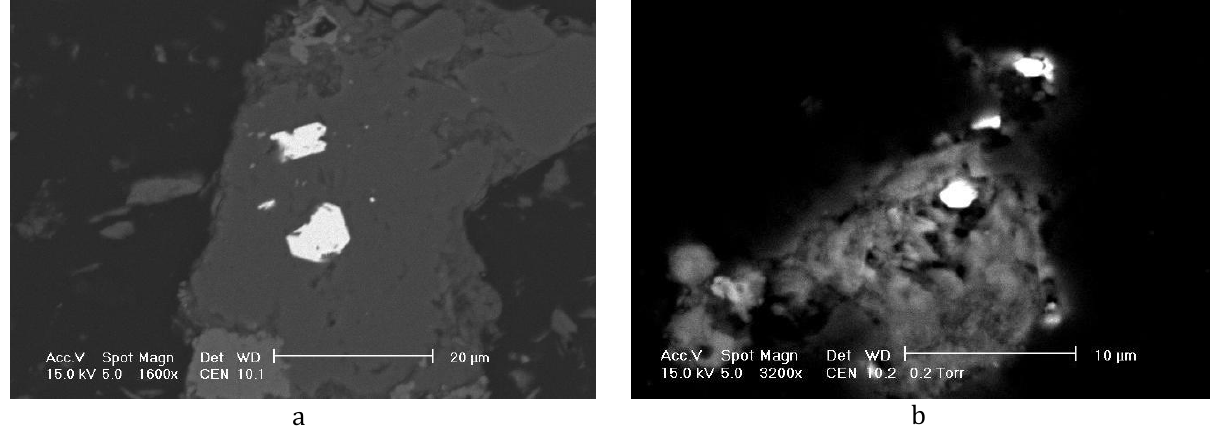
Fig. 2. SEM image of PbS particles (very bright particles) in ashes from hard coal (a) and flotation